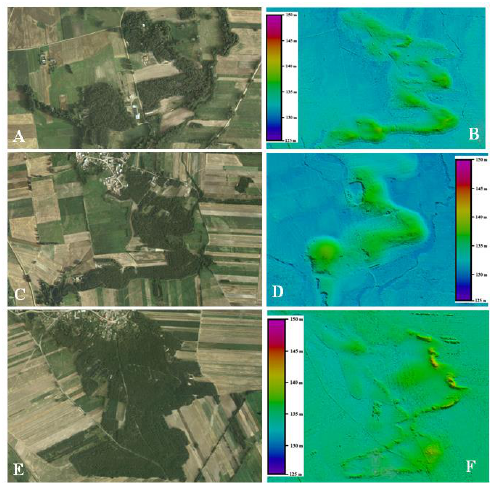
Fig. 6. Digital terrain models from LIDAR for suspected structures – objects 3-5 Figure 8. An example of archeological structure a) orthoimage b) terrain model generated on the basis of ALS point cloud